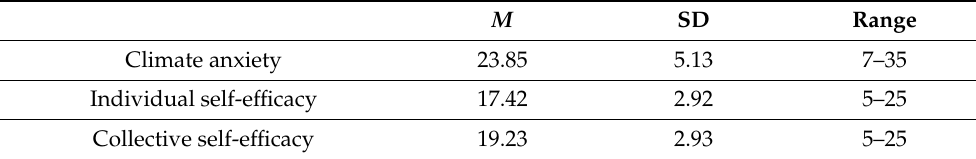
Table 2. Descriptive statistics ( n = 312).